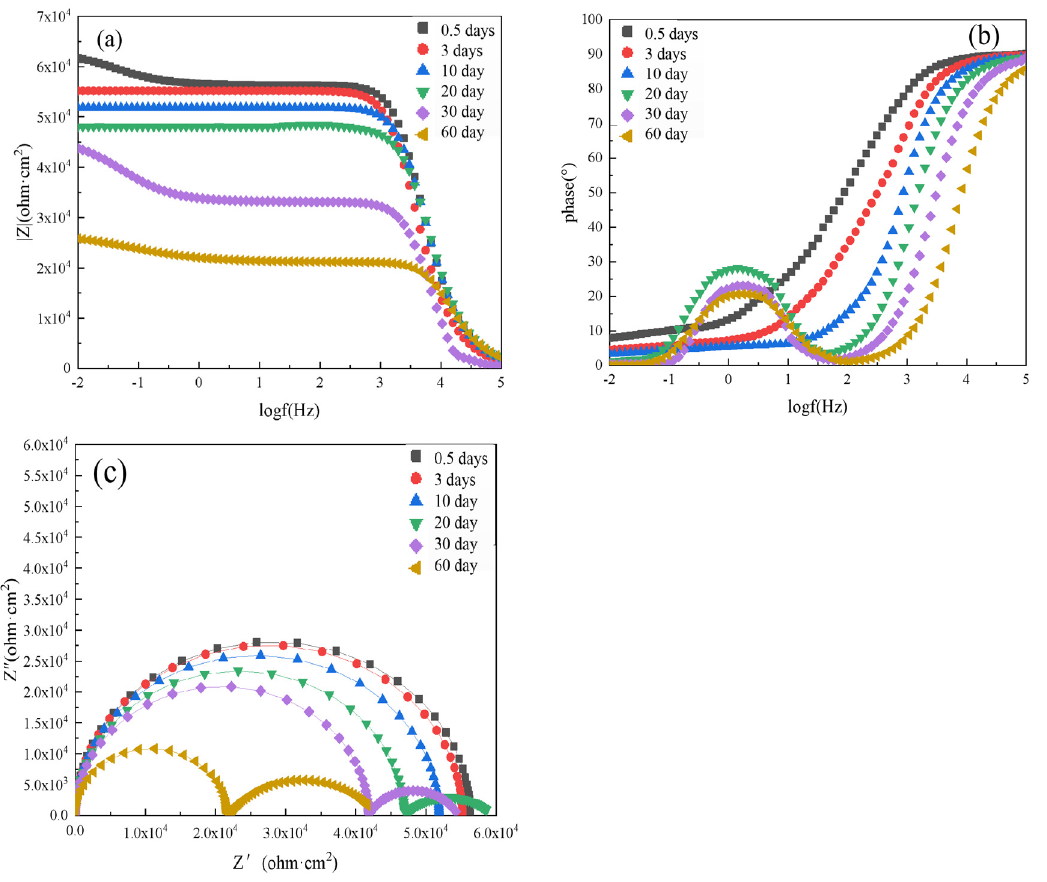
Figure 8. EIS results of unaged composite coating prepared with 6 wt.% spherical aluminum powder after immersion for various lengths of time in 3.5 wt.% NaCl solution: ( a ) Bode diagram, ( b ) phase angle diagram, and ( c ) Nyquist diagram.